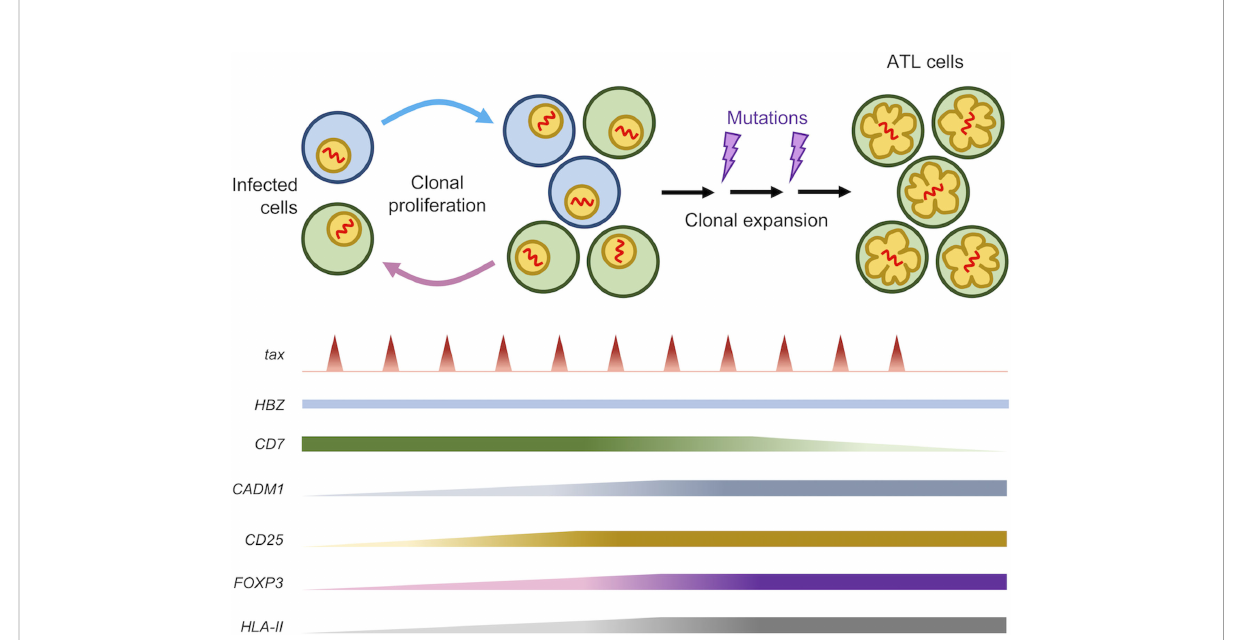
FIGURE 2 Expression pattern of several related genes during HTLV-1 persistence and leukemogenesis. After a long latency period, about 5% of HTLV-1-infected individuals develop ATL. Both Tax and HBZ are critical for leukemogenesis with the HBZ gene being constantly expressed while tax is transcribed in rare, short, self-limiting bursts. Infected cells exhibit increased expression of genes related to T-cell activation ( CD25 ) as well as Treg ( FOXP3 ). Subsequent accumulation of certain mutations during the lifetime of infected clone potentiates leukemic transformation which is accompanied by a loss of CD7 expression and an increase in CADM1 expression. Expression of CD25 and FOXP3, as well as HLA-II, is maintained throughout the latency phase as well as in ATL cells after malignant